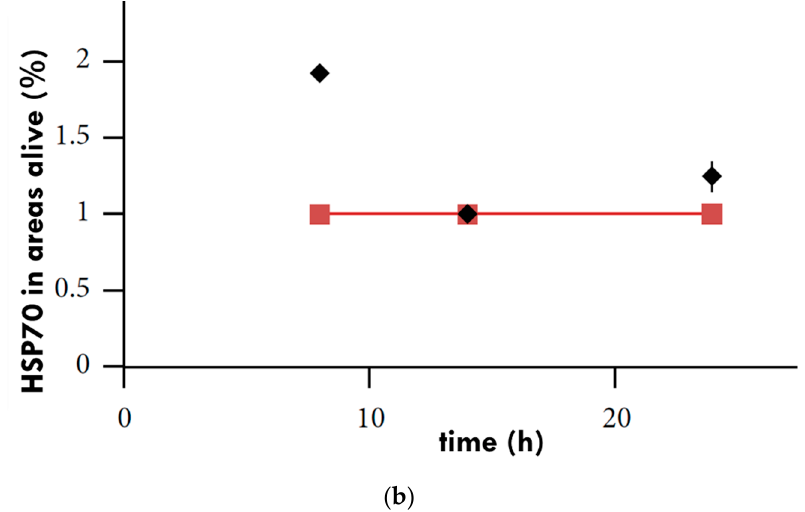
Figure 9. Relative protein expression of ( a ) HSP60 and ( b ) HSP90 in murine models. The diamonds represent HSP levels in treated tumors and the squares represent untreated tumors in the same mouse [102].